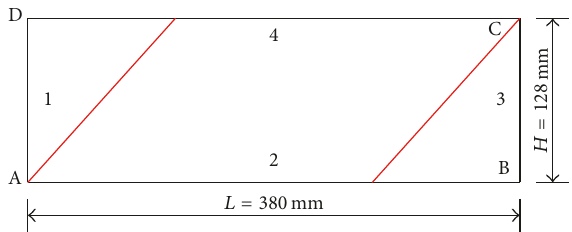
Figure 8: Rectangular Al-Kapton laminated membrane.